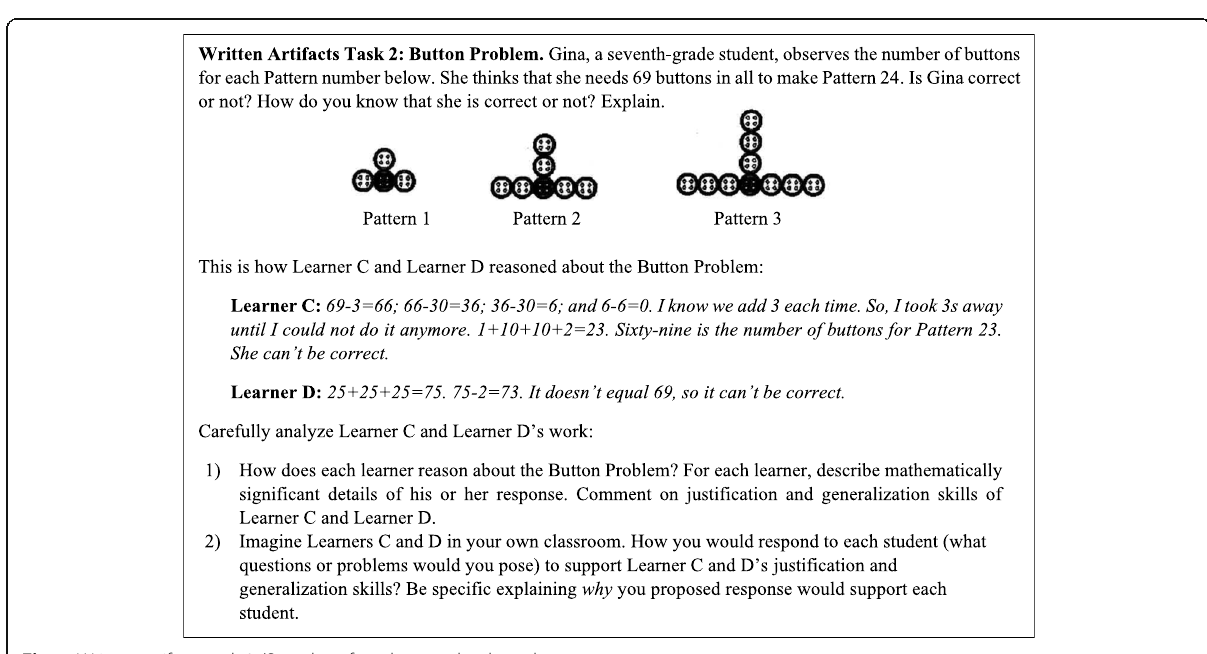
Fig. 4 Written artifacts task 2 (Samples of student work selected from